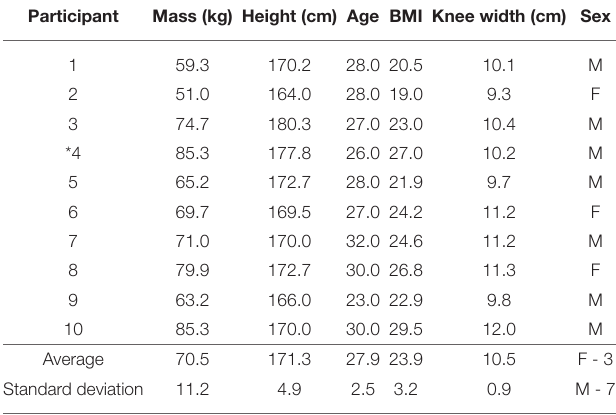
TABLE 1 | Individual details for the final 10 participants.